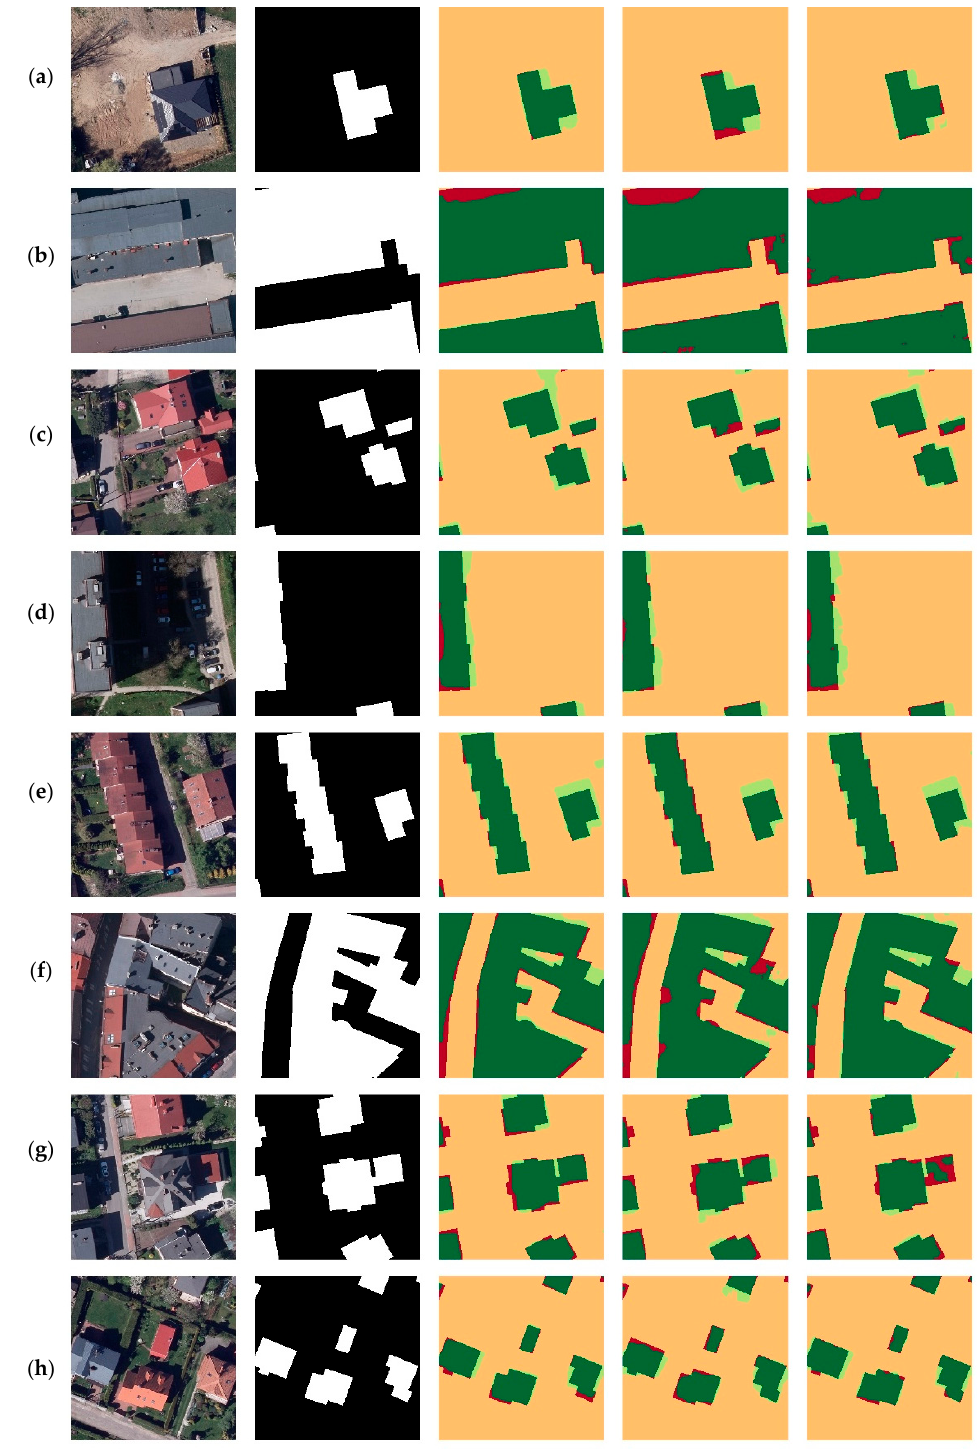
Figure 8. Visualisation of the results for the 0.1 m dataset. From left: input image, ground truth, DeepLabV3+, UNET, UNET with backbone. Colours: dark green—TP, orange—TN, light green—FP, red—FN. ( a – h ) various examples from the test dataset